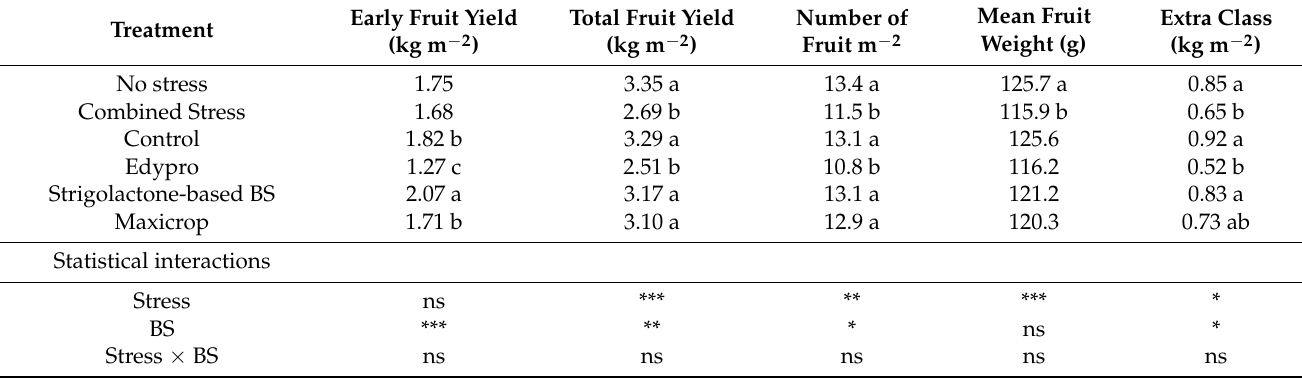
Table 4. Effects of combined restriction of water and nutrients and biostimulant (BS) application (Control: No biostimulant applied, Edypro: application of COUP É REGENERACI Ó N and PROCUAJE RADICULAR, strigolactone-based biostimulant, and Maxicrop) on tomato early and total fruit production, fruit number, fruit mean weight, and weight of fruits graded at Extra